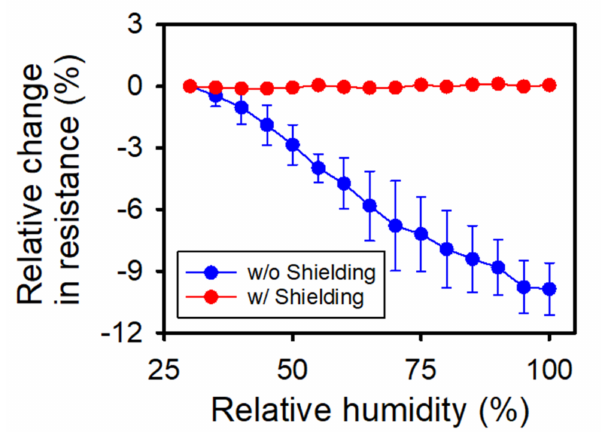
Figure 5. Relative change in resistance according to relative humidity for sensors without (blue) and with PDMS shielding (red). The blue dotted line here shares the same data with the blue dotted line in Figure 2.